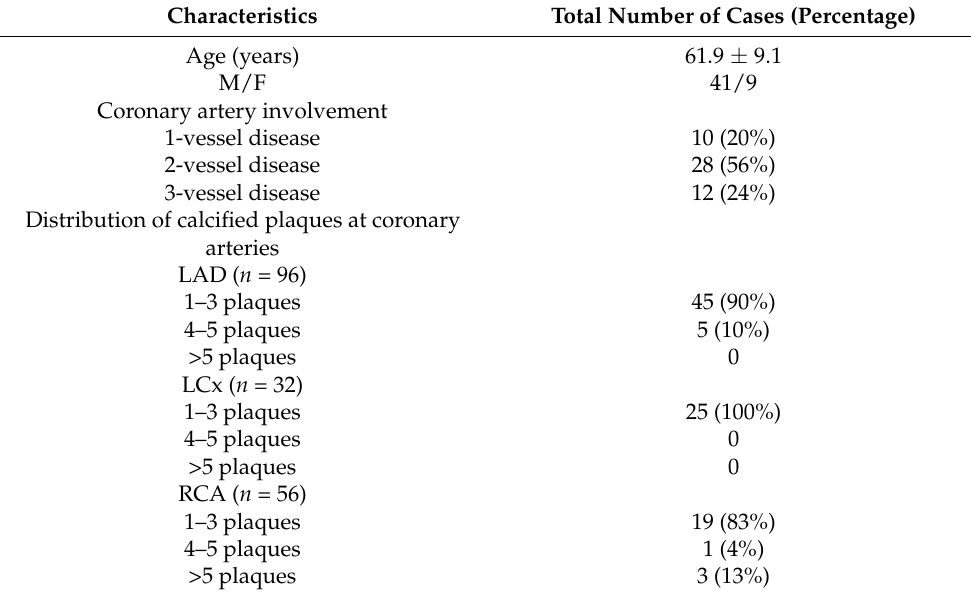
Table 1. Clinical characteristics of the study